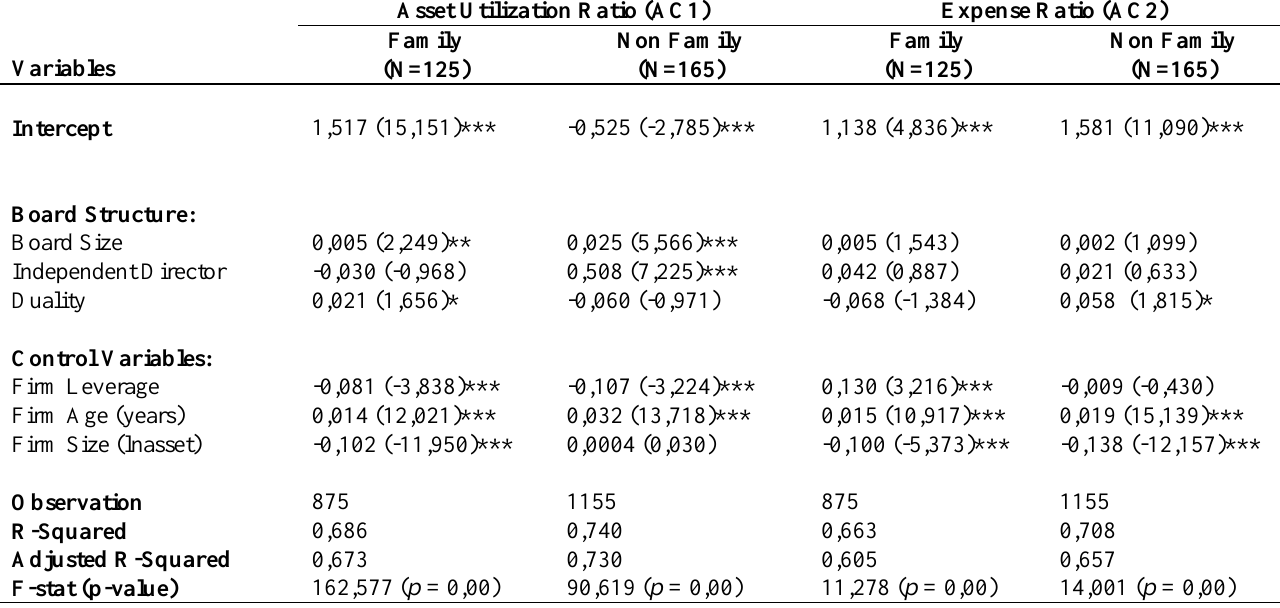
Table 4: Agency cost and corporate governance of family and non-family ownership in Malaysia